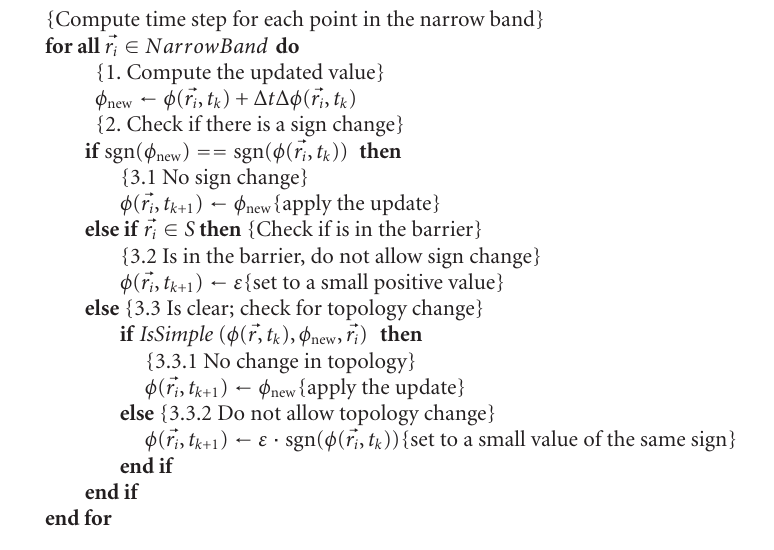
Algorithm 1: The level set function update